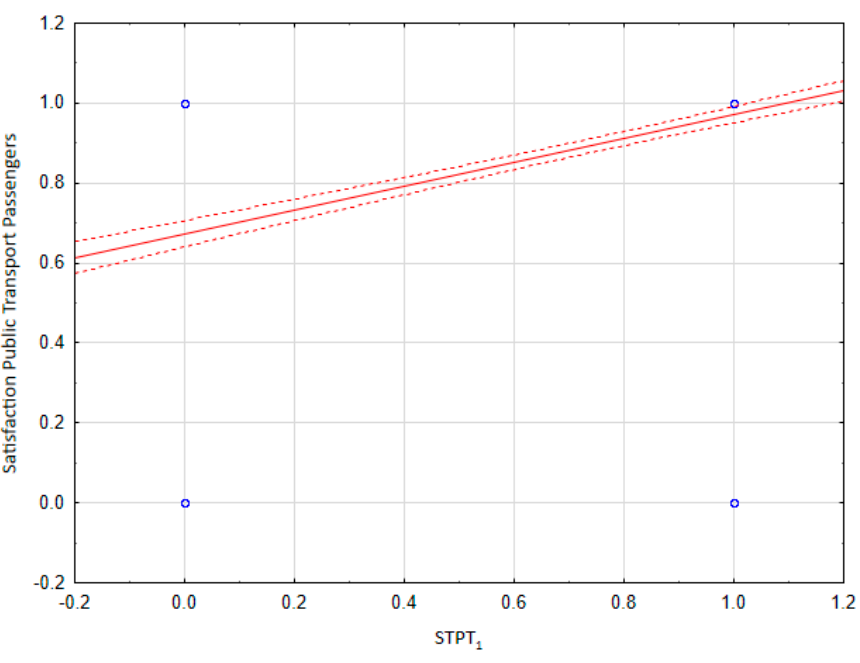
Figure 4. Sustainable urban development card.